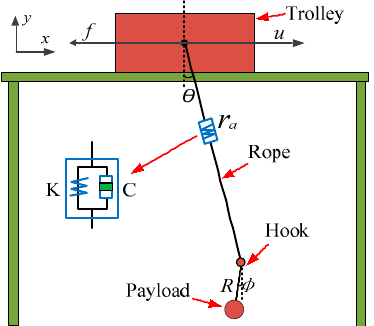
Figure 2. Equivalent double pendulum model.